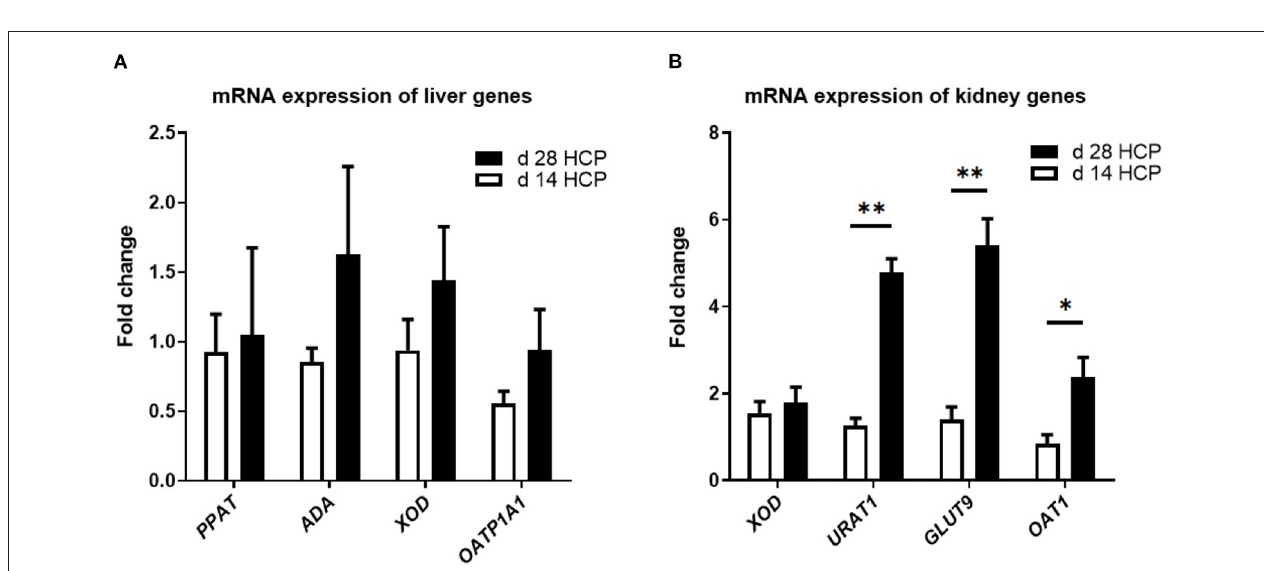
FIGURE 4 | Effect of HCP meal-based diet on the relative expression of genes related to uric acid metabolism pathway in the liver and uric acid transporter in the kidney of Magang geese on day 14 and 28. (A) ADA , PPAT , XOD , and OATP1A1 mRNA relative expression. (B) XOD , URAT1 , GLUT9 , and OAT1 mRNA relative expression. β -Actin was used as an internal control to normalize target gene transcript levels. *Mean significant difference ( p < 0.05) and **mean extremely significant difference ( p <